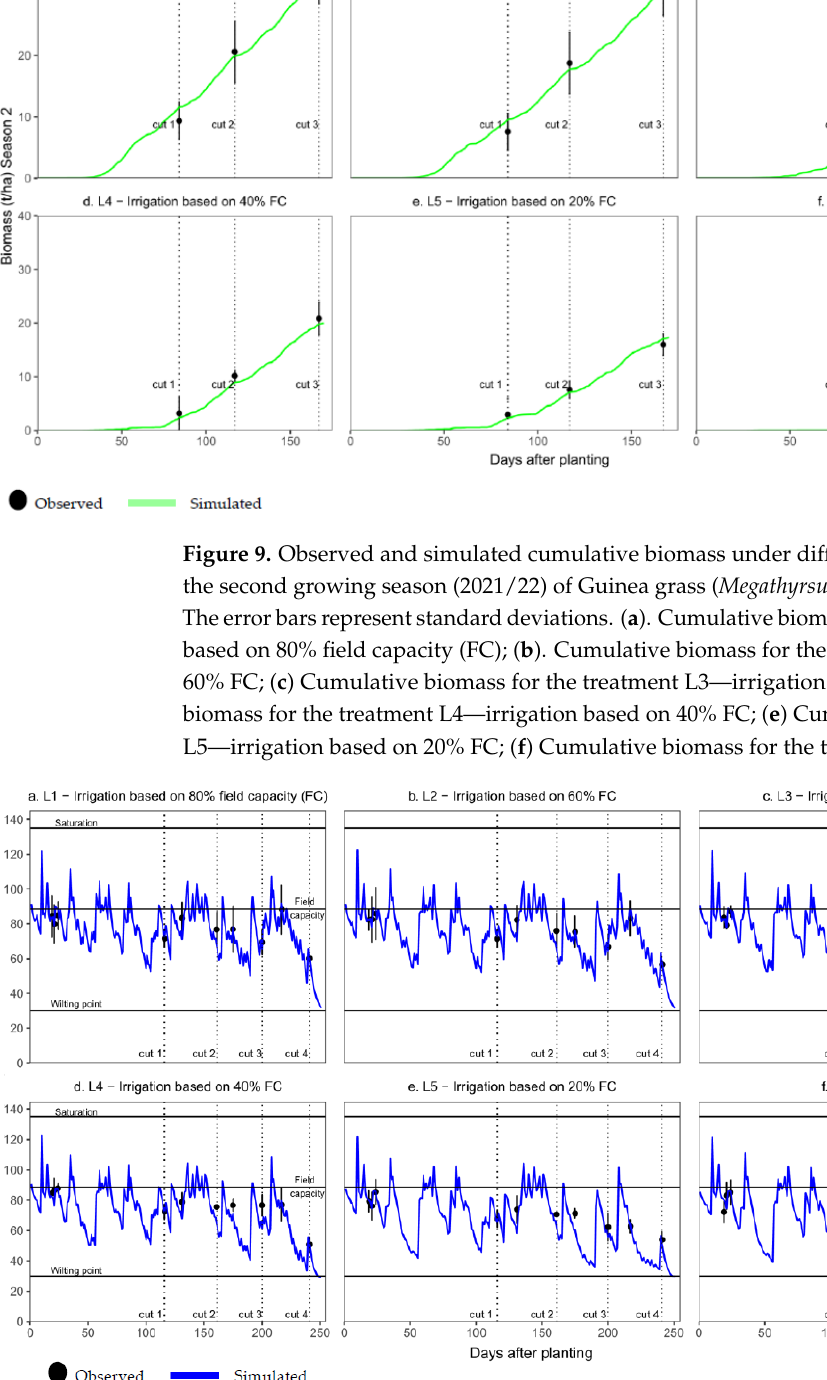
Figure 10. Observed and simulated total available soil water (TAW) under different irrigation treatments during the first growing season (2020 / 21) of Guinea grass ( Megathyrsus maximus cv. Agrosavia sabanera). The error bars represent standard deviations. (a). TAW for the treatment L1—irrigation based on 80% field capacity (FC); (b). TAW for the treatment L2—irrigation based on 60% FC; (c) TAW for the treatment L3—irrigation based on 50% FC; (d) TAW for the treatment L4—irrigation based on 40% FC; (e) TAW for the treatment L5—irrigation based on 20% FC; (f) TAW for the treatment L6—rainfed.